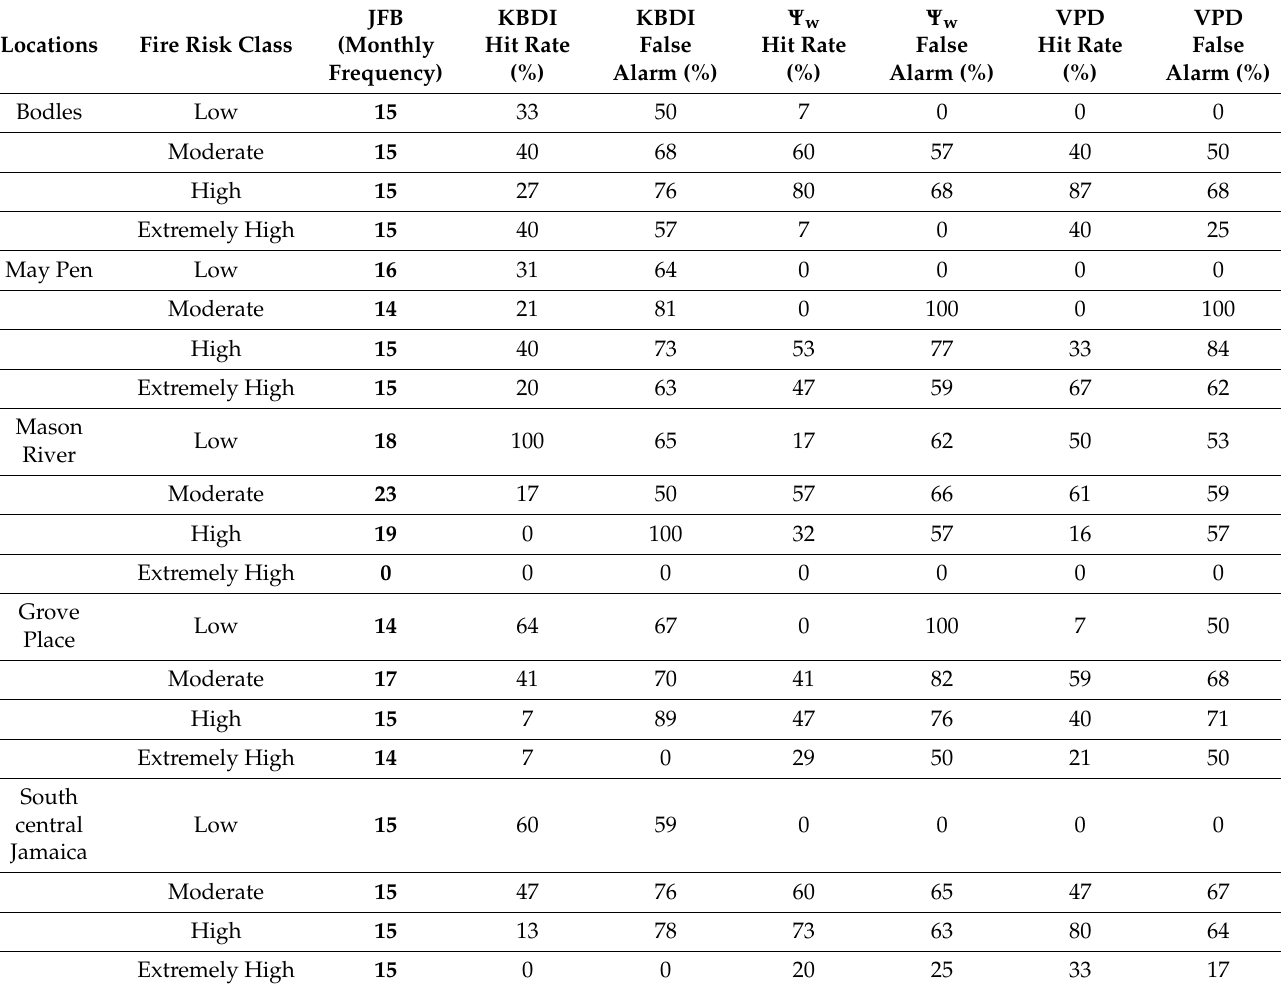
Table 4. Categorical skill of KBDI, VPD, Ψ w in representing the risk category’s monthly frequency deduced from JFB for 2013–2017 using station